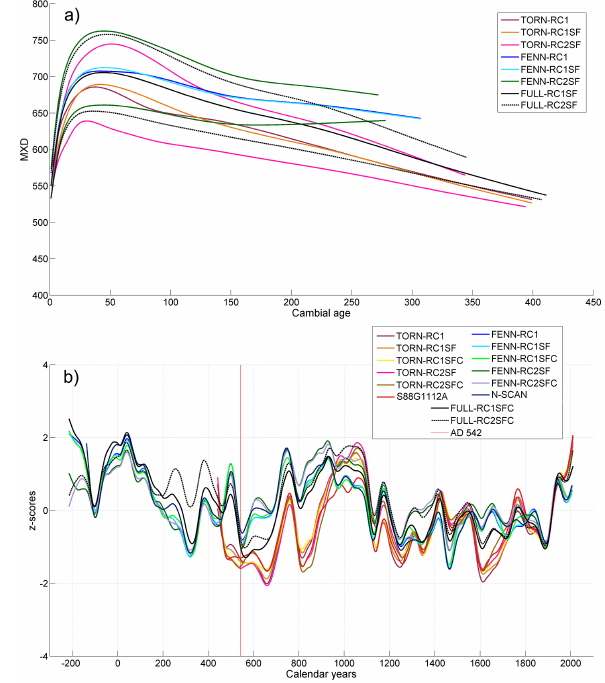
Figure 3. Regional curves (a) and chronologies (b) for TORN, FENN and FULL data sets and different types of standardization. All the chronologies are smoothed with 100yr splines. Variance and mean standardized to the period AD 1802–2006, 15yr smoothed data are used for variance adjustment. S88G1112A (Melvin et al., 2013) and N-SCAN (Esper et al., 2012) are original chronologies for the TORN and FENN data sets,